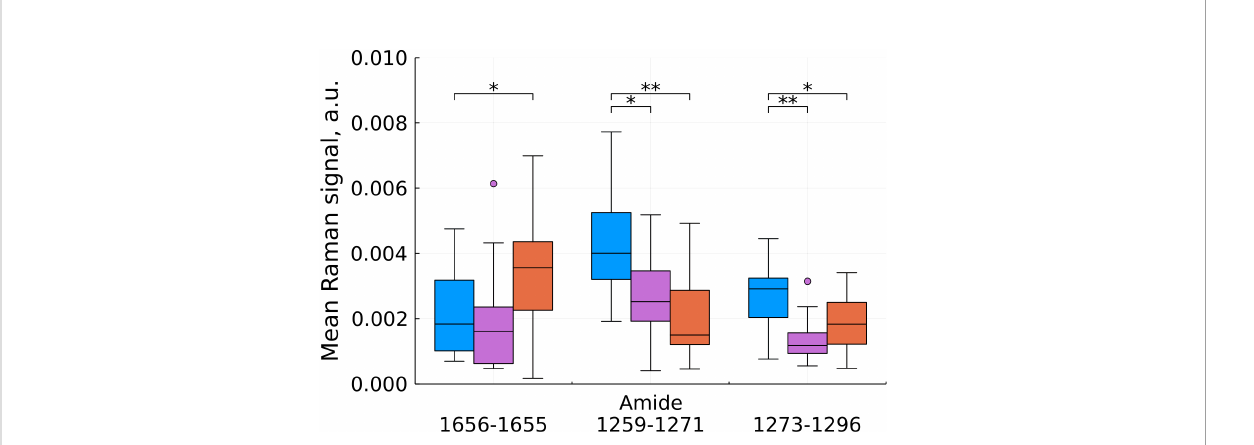
FIGURE 3 Mean Raman signal in amide bands (blue – normal tissue, magenta - tumor edge, orange - tumor center). Numbers in horizontal labels denote the range of Raman shifts. *p<0.05,